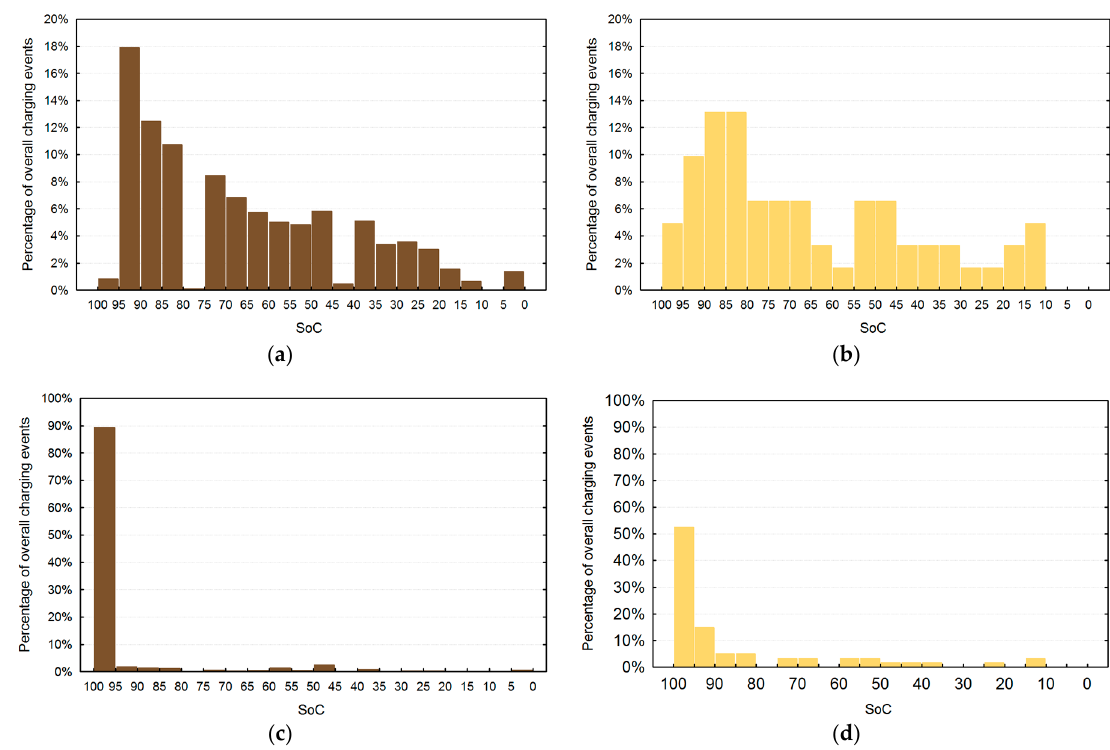
Figure 8. Charging behavior—state of charge ( SoC ) at the beginning and the end of charging events: ( a ) SoC at the start of charging event—car-sharing company; ( b ) SoC at the start of charging event—co-housing; ( c ) SoC at the end of charging event—car-sharing company; and ( d ) SoC at the end of charging event—co-housing.